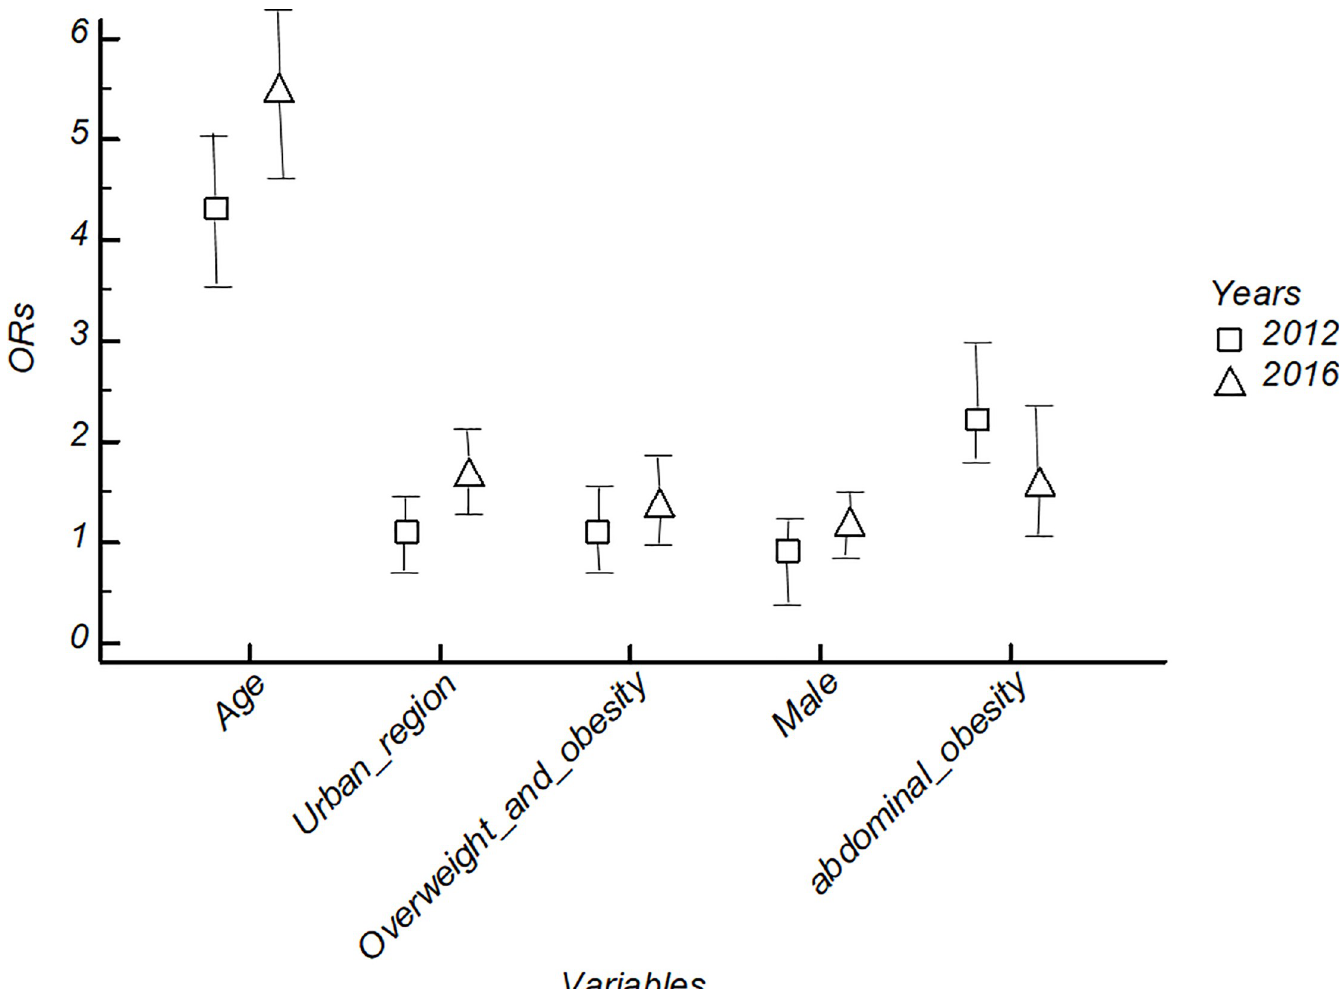
Fig 4. Odds ratio of arterial hypertension by supposed risk factors in 2016 and